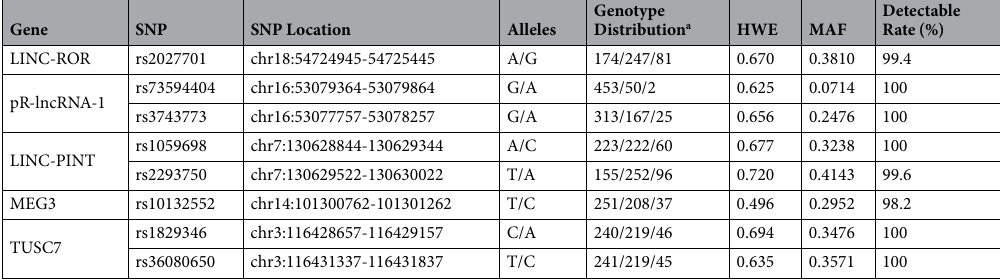
Table 2. Genotype distribution and MAF of 8 SNPs in LINC-ROR , pR-lncRNA-1 , LINC-PINT , MEG3 and TUSC7 . a In the order of wild homozygote/heterozygote/mutant homozygote. Abbreviations: HWE, Hardy- Weinberg equilibrium; MAF, minor allele frequency (Southern Han